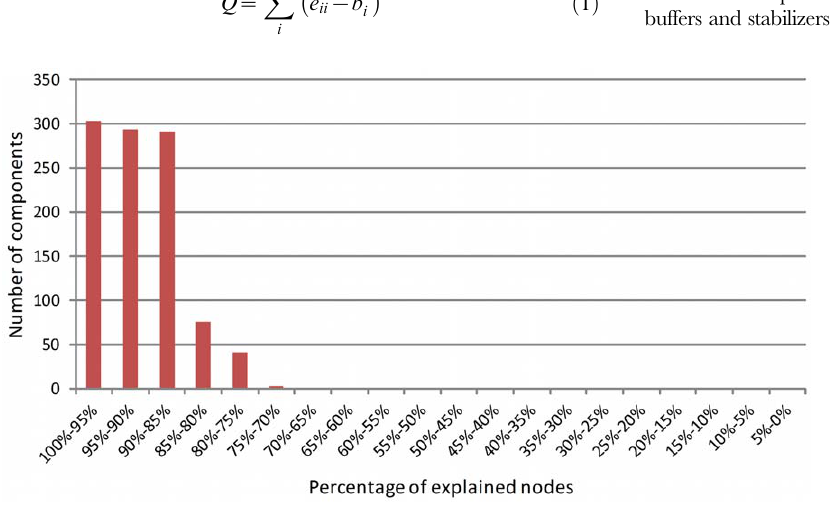
Figure 9. Number of components analysed that have a given percentage of explained nodes (i.e. nodes that have a homogeneous strategy with their communities, or border nodes with a different strategy to that in their community).